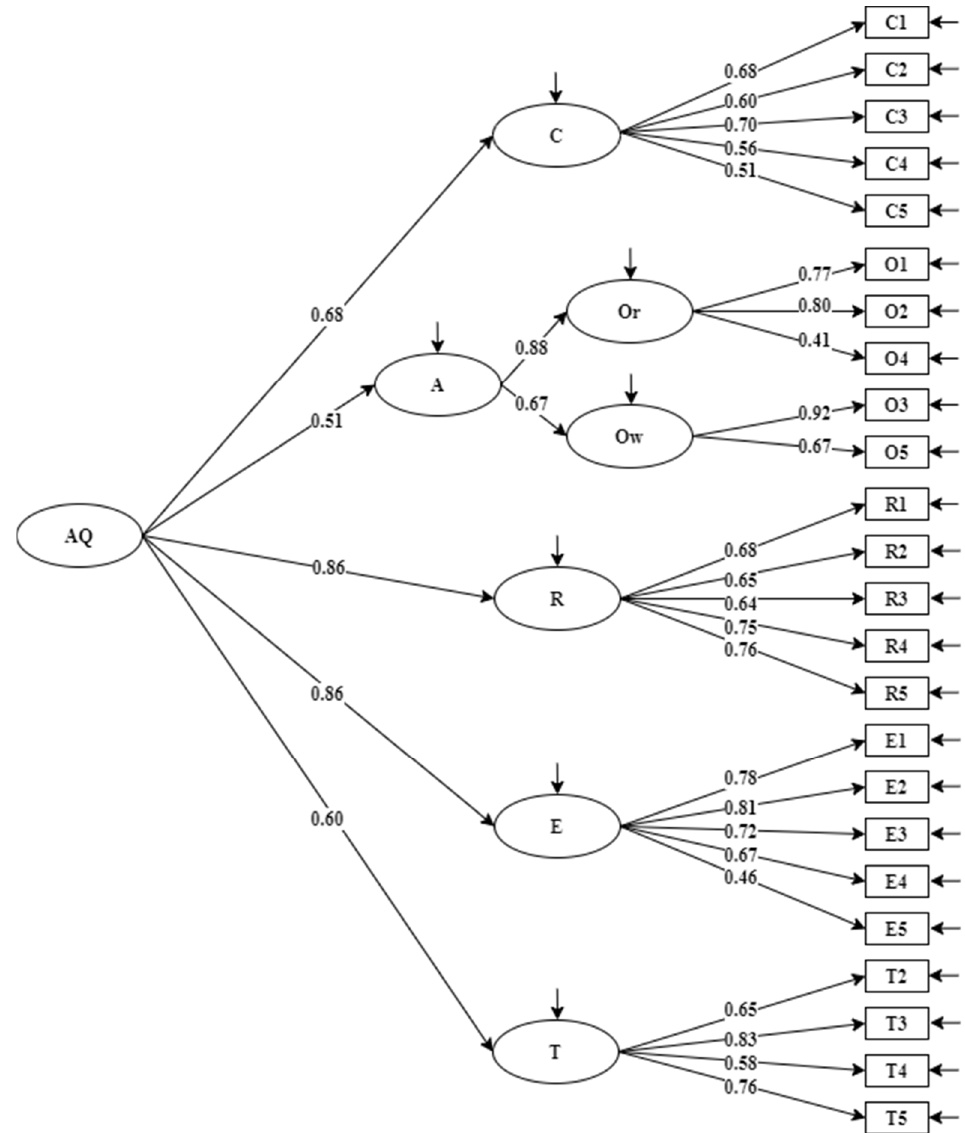
Figure 3. Model 3 with standardized factor loadings on control (C) and attribution (A), which consists of ownership (Ow), origin (Or), reach (R), endurance (E), transcendence (T), and adversity quotient (AQ) ( n = 242).